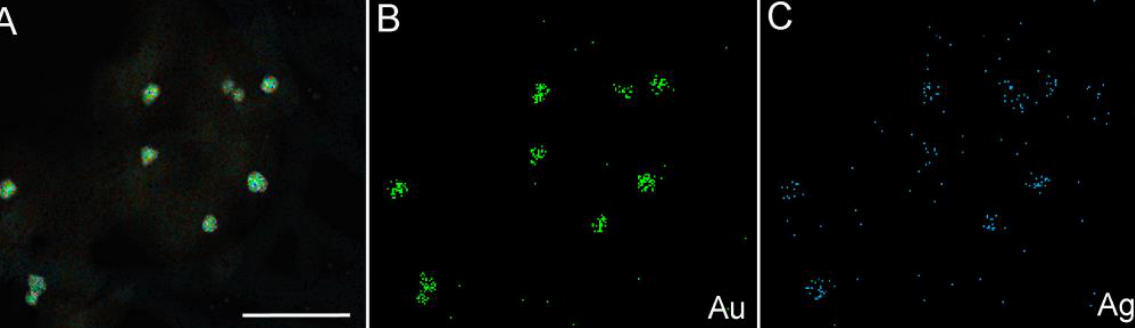
Figure 4. Detailed HAADF-STEM image of AuAg-g-C 3 N 4 nanohybrid 3 displaying a 4 nm size metal nanoparticle. EDS elemental mapping images for elements Au and Ag: image ( A ) displays both elements mapping at a time, while images ( B , C ) display the individual Au and Ag elemental maps, respectively (bar corresponds to 10 nm). XPS analysis was carried out in order to gain insight into the surface elemental com- position and the elemental chemical states of the atoms forming AuAg-g-C 3 N 4 nanohy- brids 2 – 3 (see Figure 5 for 3 and Supplementary Materials for pristine g-C 3 N 4 1 and nano- hybrid 2 ). The wide XPS spectra display the presence of intense peaks corresponding to C and N, meanwhile small peaks assigned to O, Au and Ag can also be detected. From the anal- ysis of these wide spectra, it can be observed that the % wt composition of Ag and Au atoms is 0.9 and 0.9% (2) and 1.7 and 1.3% (3), respectively, pointing to some loss of g- C 3 N 4 in the experimental workup, since a 0.5% wt (2) or 1% wt (3) of metals (gold + silver) was added in the preparation of nanohybrids 2 and 3 . It is also worth mentioning that the amount of oxygen (1.8% wt (2) or 2.3% wt (3)) is larger than the one obtained for pristine g-C 3 N 4 1 (0.78% wt) pointing to an enrichment of oxygen species at the surface of this semiconductor, probably due to the synthetic thermal conditions in ethylene glycol. This result is similar to a previously reported one, in which the microwave treatment of g-C 3 N 4 in ethanol led to an increased density of oxygen-containing species (-OH groups) at the g- C 3 N 4 surface, conferring a higher hydrophilicity, better charge carrier separation and pol- lutant adsorbance [26]. In our case the presence of an increased amount of hydroxyl groups in AuAg-g-C 3 N 4 nanohybrids 2 – 3 would favor the charge carrier separation. Figure 5b depicts the high-resolution XPS spectrum for the C 1s region for nanohy- brid 3 , which is fitted into four peaks. The intense peak at 288.3 eV is assigned to the sp 2 carbon atoms in the triazine units of g-C 3 N 4 (C − N = C), supported by the presence of the weak peak component of the C 1s region at 293.6 assigned to double bond π-excitations. The peak at 288.8 eV would be related to C-O bonds, meanwhile the peak at 285.1 is asso- ciated to C-C bonds [27,28]. In addition, Figure 5c provides the high-resolution spectrum